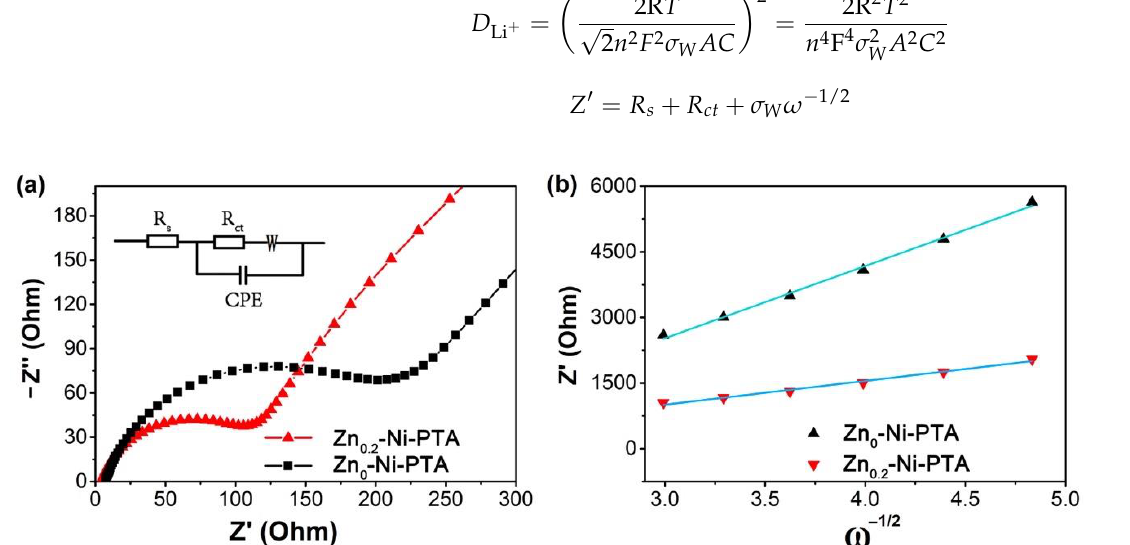
Figure 4. ( a ) Nyquist plot of Zn 0.2 -Ni-PTA and Zn 0 -Ni-PTA. ( b ) Z’ vs. ω − 1/2 plots in low frequency region.